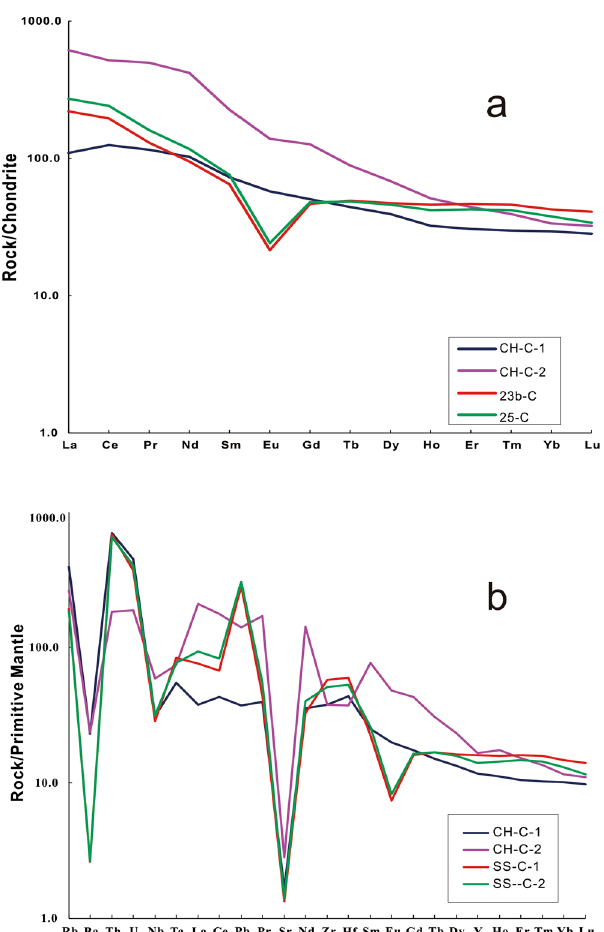
Figure 6. ( a ) Chondrite-normalized REE patterns. ( b ) Primitive mantle-normalized trace element patterns of the PTB volcanic ashes in South China. Chondrite and PM normalizing values from Sum and McDonough 37